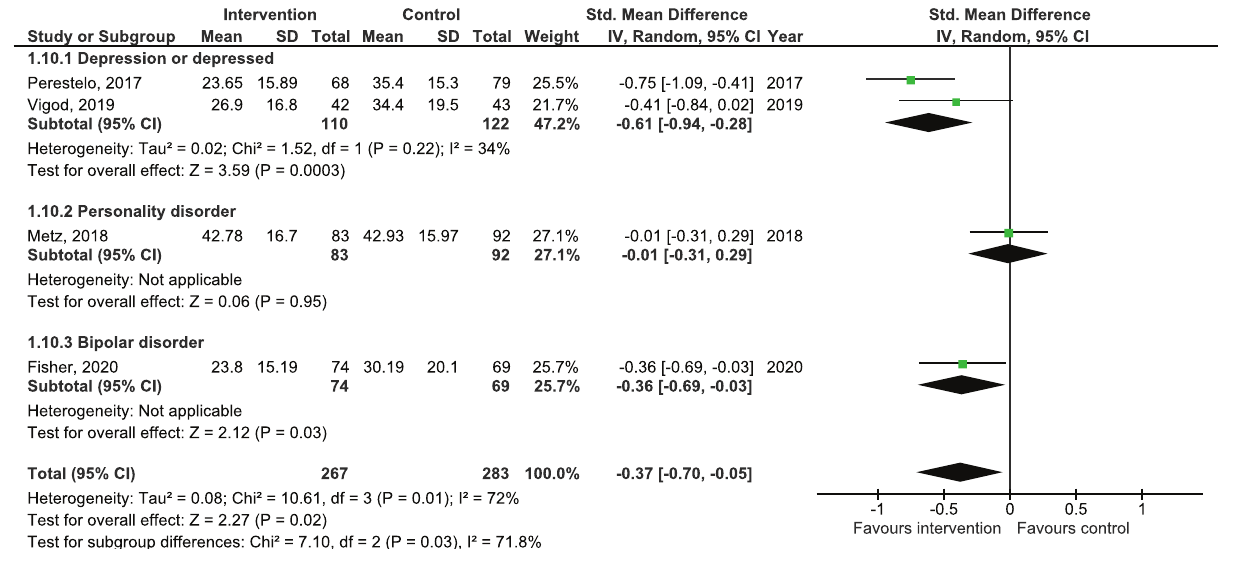
FIGURE 12 | Forest plot for decisional conflict by